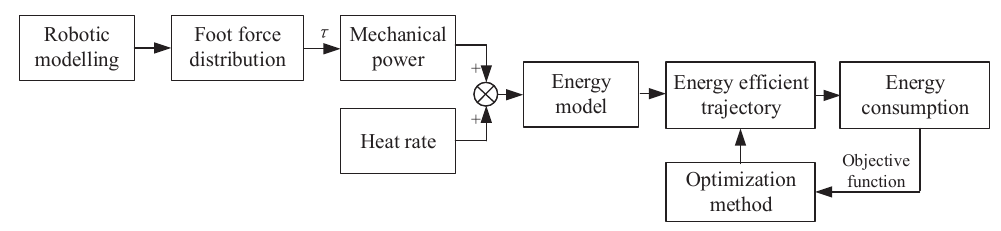
Figure 3. Routine to obtain energy efficient